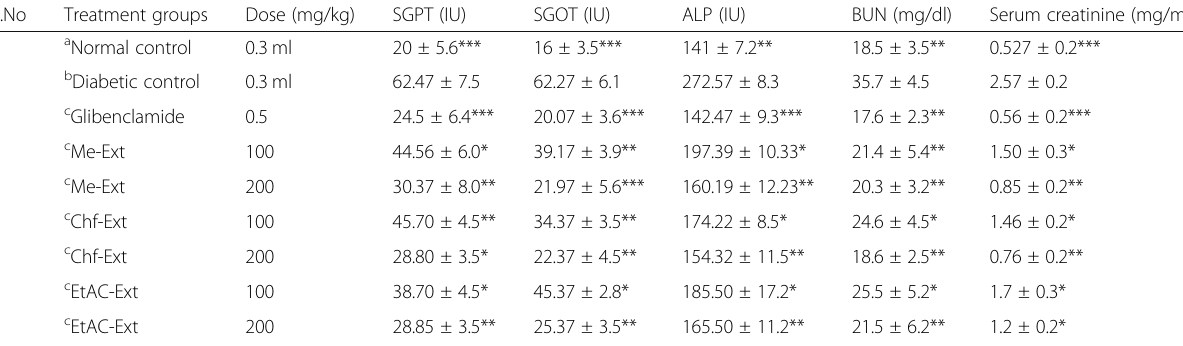
Table 6 Effect of E. umbellata fruit extract/fractions on liver and renal functions in streptozotocin-induced diabetic rats S.No Treatment